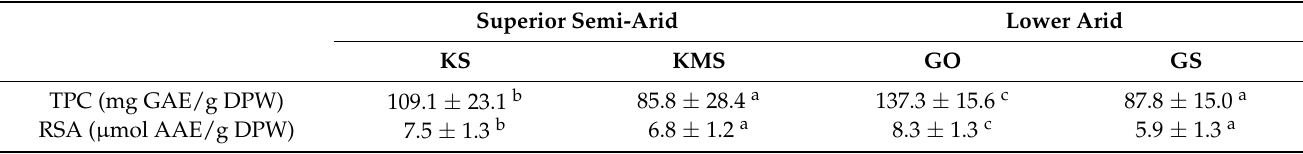
Table 2. Total phenolic content (TPC) and Radical Scavenging Activity (RSA,) of methanolic rosemary extracts from the different bioclimatic